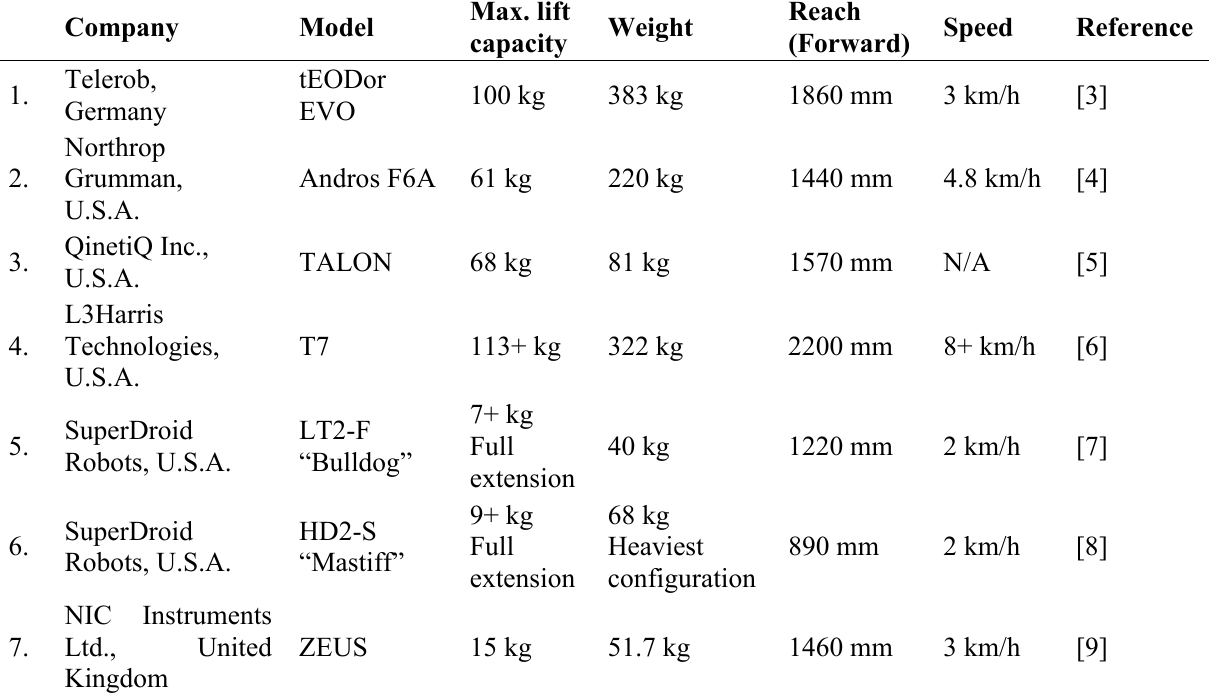
Table 1. EOD robots available on the